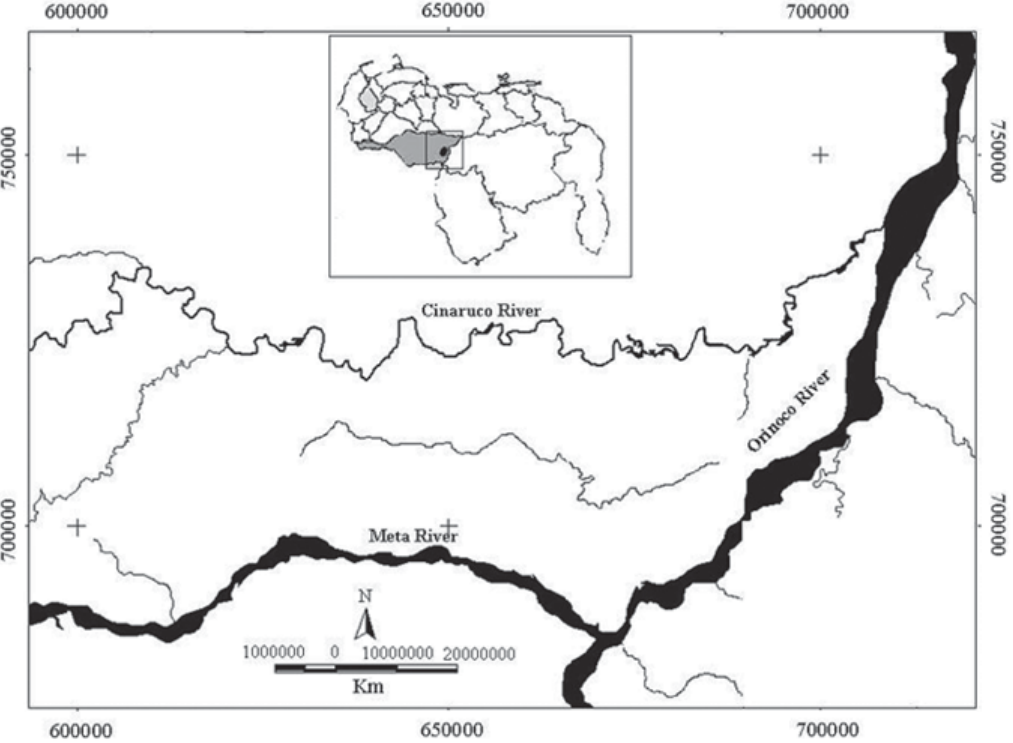
Fig. 2. Map showing location of the Cinaruco River, a tributary of the Orinoco River in Venezuela’s Apure State; the study reach is outlined with a